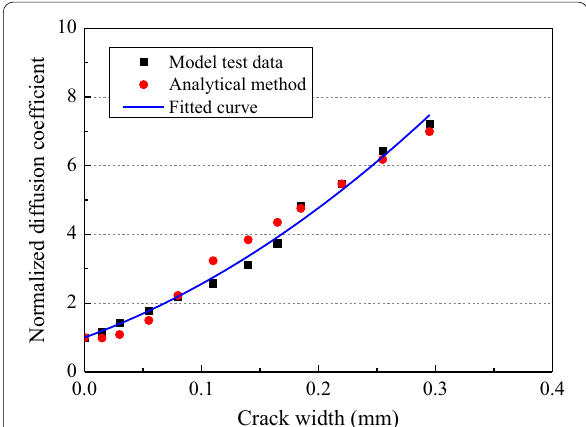
Fig. 4 Variation of normalized diffusion coefficient with crack width.